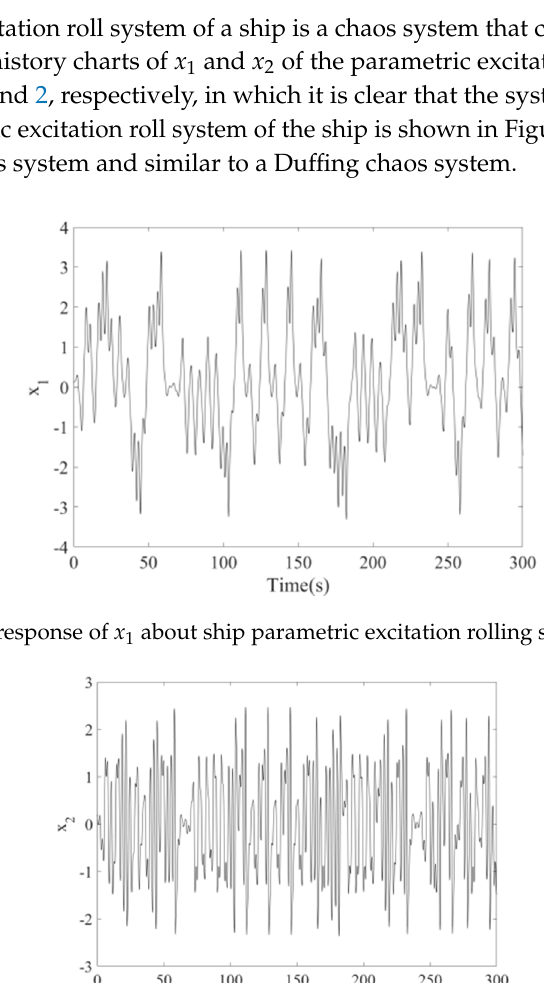
Figure 2. The time response of 2